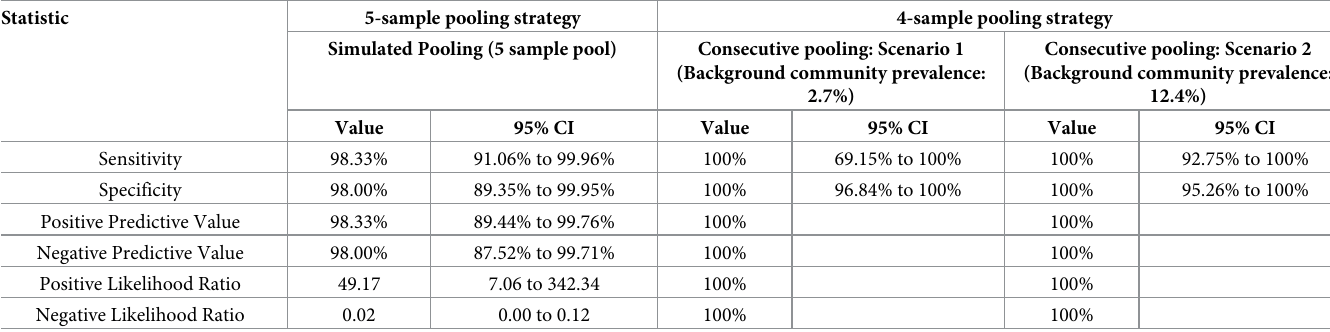
Table 3. Performance characteristics of the 4 and 5 samples pooling